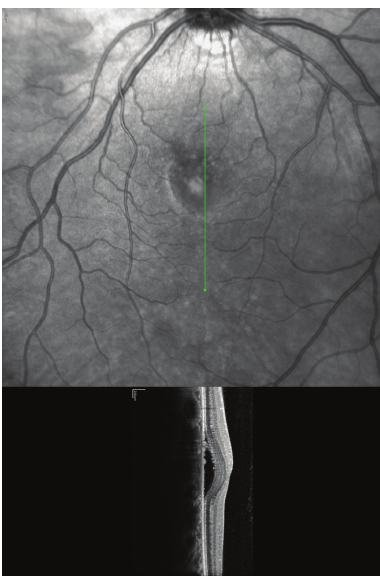
Figure 1: Fundus photograph and optical coherence tomography of the left eye of Patient 1, 19 days after PRK, showing serous retinal detachment consistent with